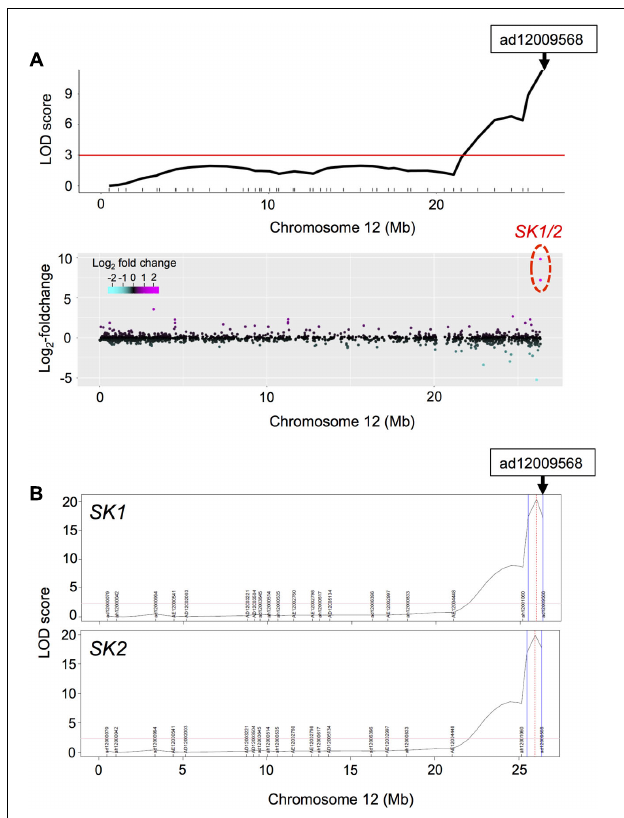
FIGURE 3 | Phenotypic QTL (phQTL) and eQTL for SK1 / 2 . (A) LOD statistics of phQTLs for total internode length (TIL) on chromosome 12 are shown (upper panel). The differential expressions between non-deepwater- and deepwater-type RILs are plotted along the physical genome position in log 2 -fold change (bottom panel). Note that transcription factors SK1 and SK2 exist in Bhadua but not in T65 plants. The red horizontal line indicates LOD = 3. (B) LOD statistics of eQTLs for SK1 / 2 gene expressions. Vertical blue lines represent support interval for the detected